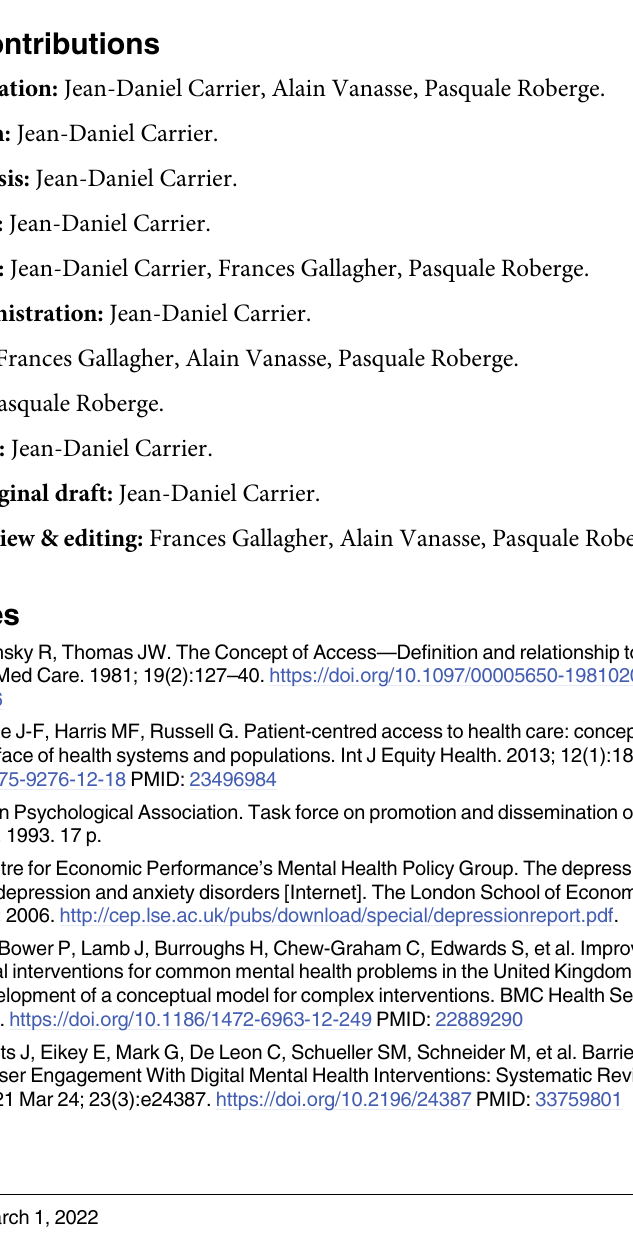
S1 Table. Description of the documents included (n = 94), by publication